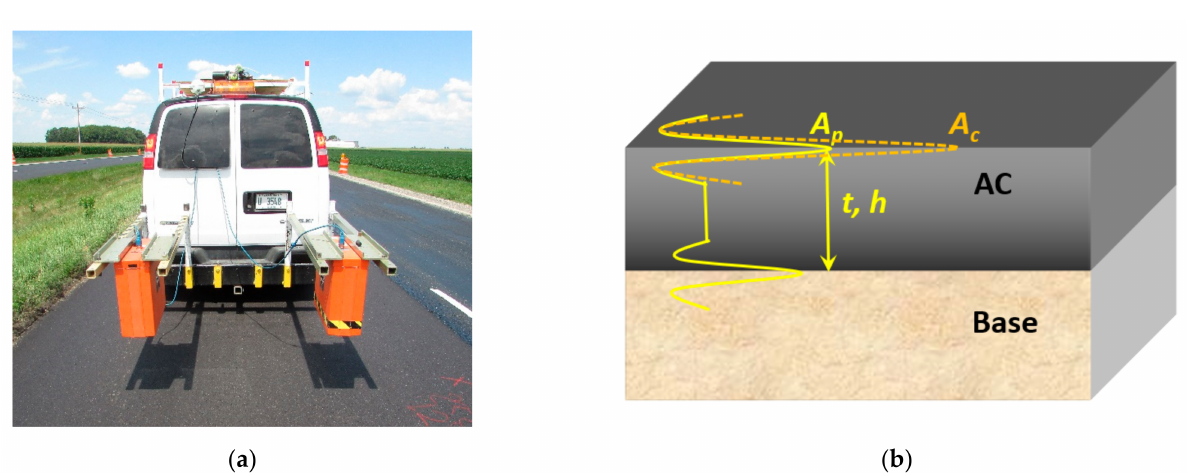
Figure 1. The ground-penetrating radar (GPR) survey configuration and received signal of GPR from field tests ( a ) and reflected signal from interface of layers ( b